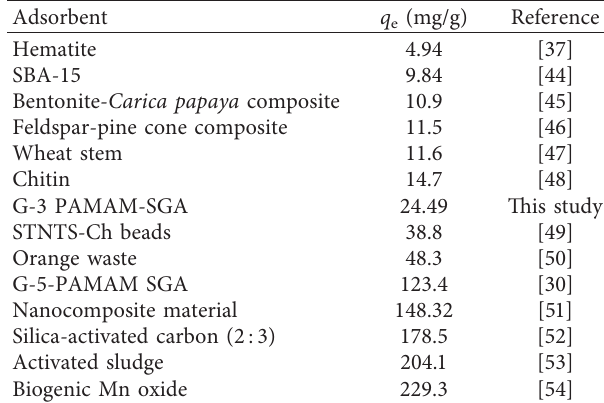
Table 6: Comparison of G-3 PAMAM SGA Cd(II) adsorption capacity with some adsorbents reported in the